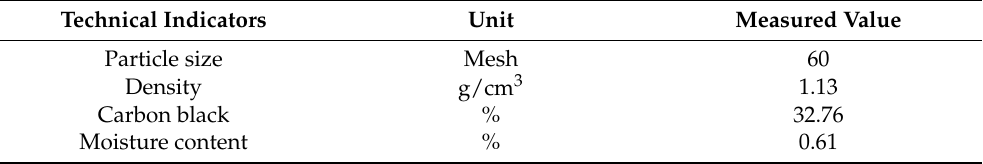
Table 4. Basic technical indexes of